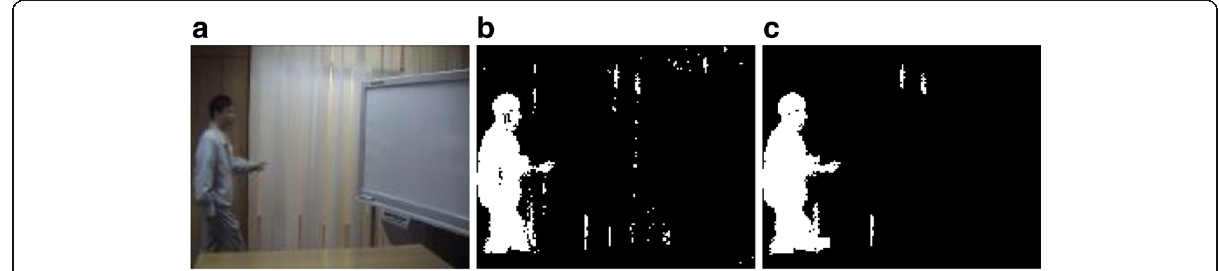
Fig. 7 Probabilistic object refinement. a Original image frame. b Segmented human without refinement. c Segmented human with probabilistic